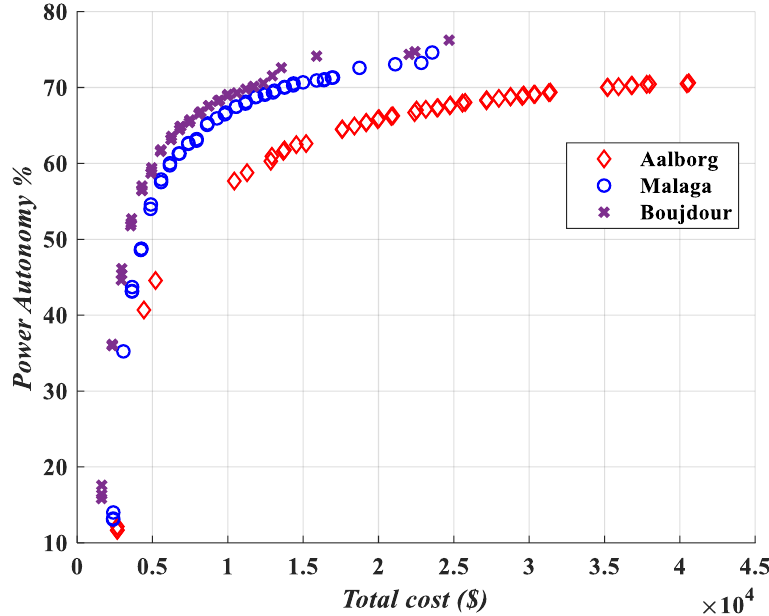
Figure 5. Pareto-optimal solutions of different power autonomy levels at different values of total cost in a commercial area.